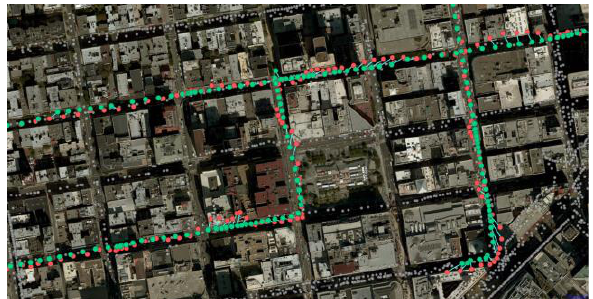
Figure 1. Original photo locations (in red) and corrected locations (in green) estimated through a photogrammetric